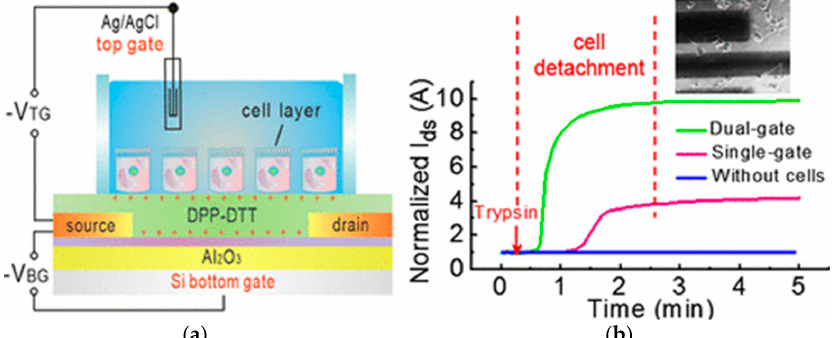
Figure 18 . ( a ) Architecture of the dual-gate transistor, with a Ag/AgCl top gate and cells attached to the DPP-DTT semiconductor (poly[2,5-(2-octyldodecyl)-3,6-diketopyrrolopyrrole-alt-5,5-(2,5-di(thien-2-yl)thieno[3,2-b]thiophene)]; ( b ) time-dependent drain current curves showing cells detachment upon addition of trypsin. Reprinted with permission from Zhang et al. [88]. Copyright © 2017 American Chemical Society.